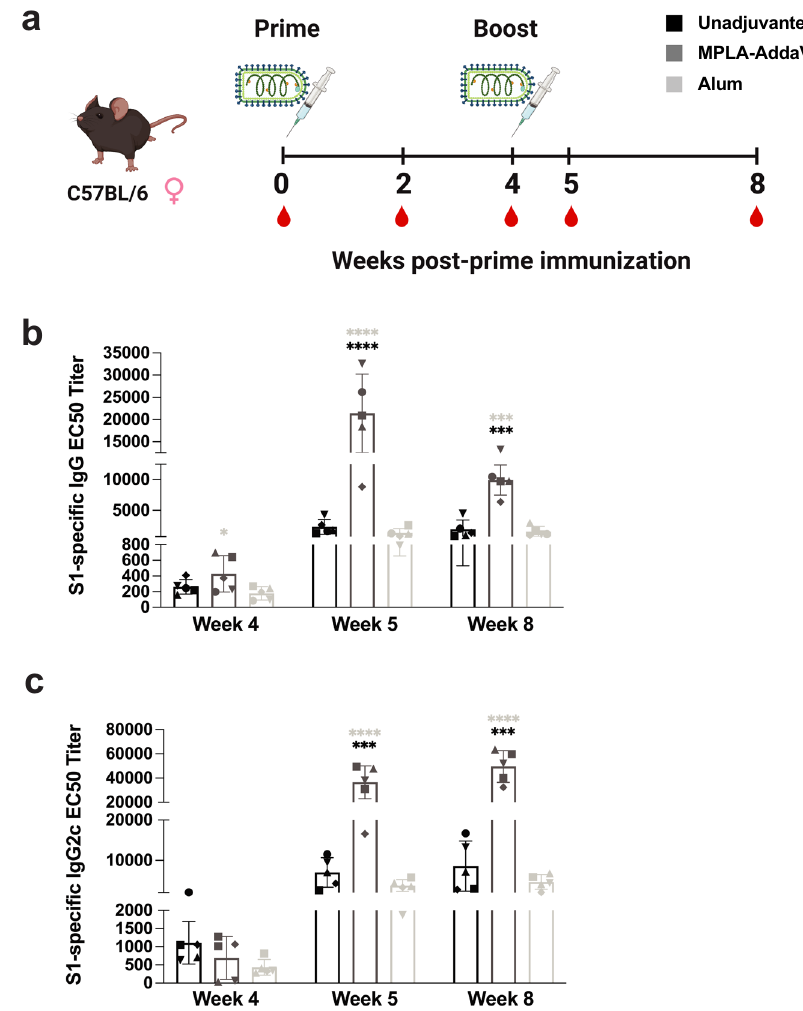
Fig. 1 Adjuvant comparison in RABV-vectored SARS-CoV-2 vaccine CORAVAX. a Schematic of the immunization schedule in C57BL/6 mice ( n = 5 per group, female) with prime and boost of indicated adjuvant groups. Mice were immunized with 10 µg of CORAVAX without adjuvant, with MLPA-AddaVax, or with alum at day 0 and week 4. Sera were collected at 2, 4, 5, and 8 weeks post-immunization and analyzed by ELISA. b S1-speci fi c IgG ELISA at weeks 4, 5, and 8 post-prime immunization was reported as average half-maximal effective concentration (EC50) titer (bars) determined from individual mouse serum (symbols) ELISA curves. c Average EC50 titers (bars) determined from individual mouse (symbols) ELISA curves of anti-S1 serum IgG2c antibodies at weeks 4, 5, and 8. Error bars represent the standard deviation (SD) from the mean. Statistics are by one-way ANOVA with post-hoc Tukey ’ s test of log-transformed EC50 titers. p > 0.1234 (ns), p < 0.0332 (*), p < 0.0021 (**), p < 0.0002 (***), p < 0.0001